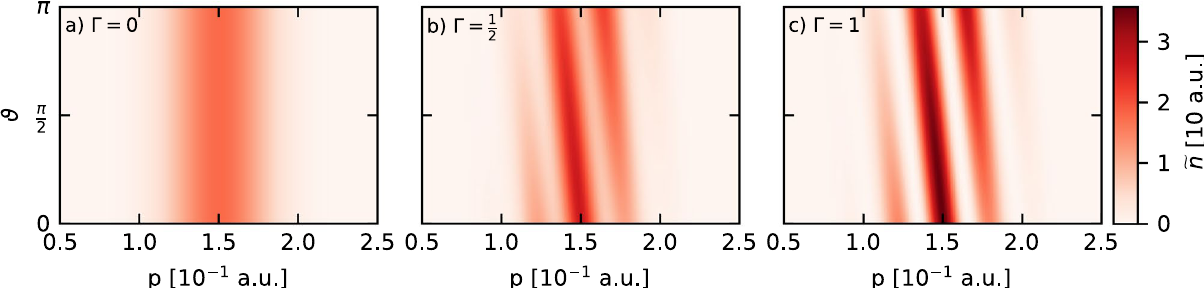
Figure 2. Influence of the relative phase ϑ on the probability density in momentum space, of the quality parameter Ŵ . For a Ŵ = 0 , and